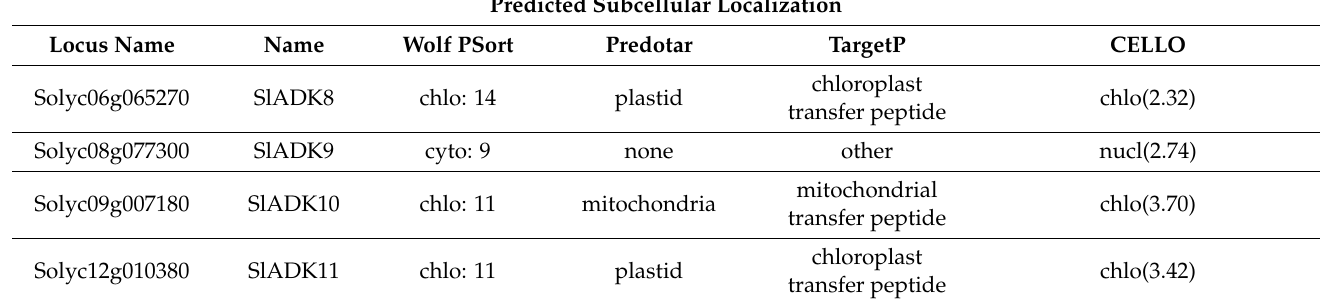
Table 2. Cont. Predicted Subcellular